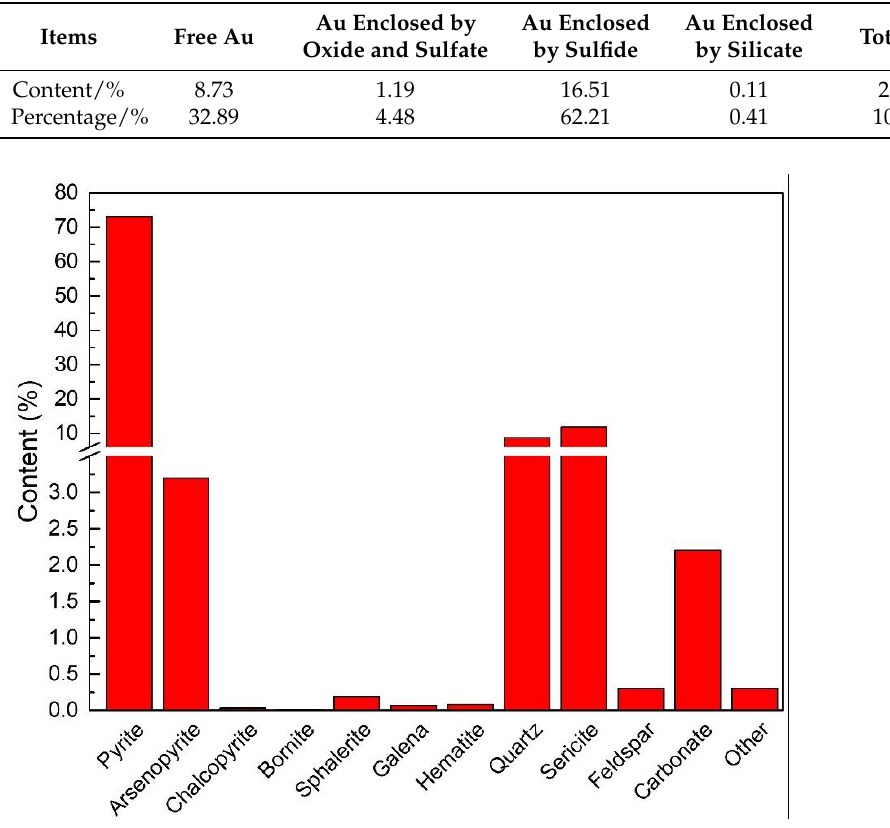
Table 3. Gold chemical phase of gold concentrate samples.